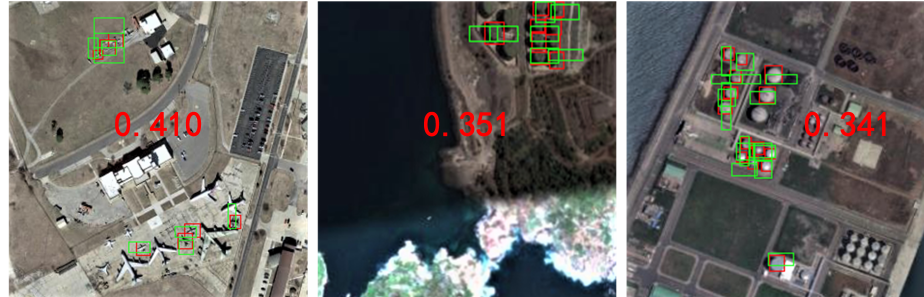
Figure 2. Small objects in the dataset and their corresponding positive anchors under the Faster R-CNN framework. The GT box is represented by a red rectangle, and the positive anchors corresponding to the GT box are represented by green rectangles. Numbers in the images are the average IoUs of the positive anchors corresponding to the small